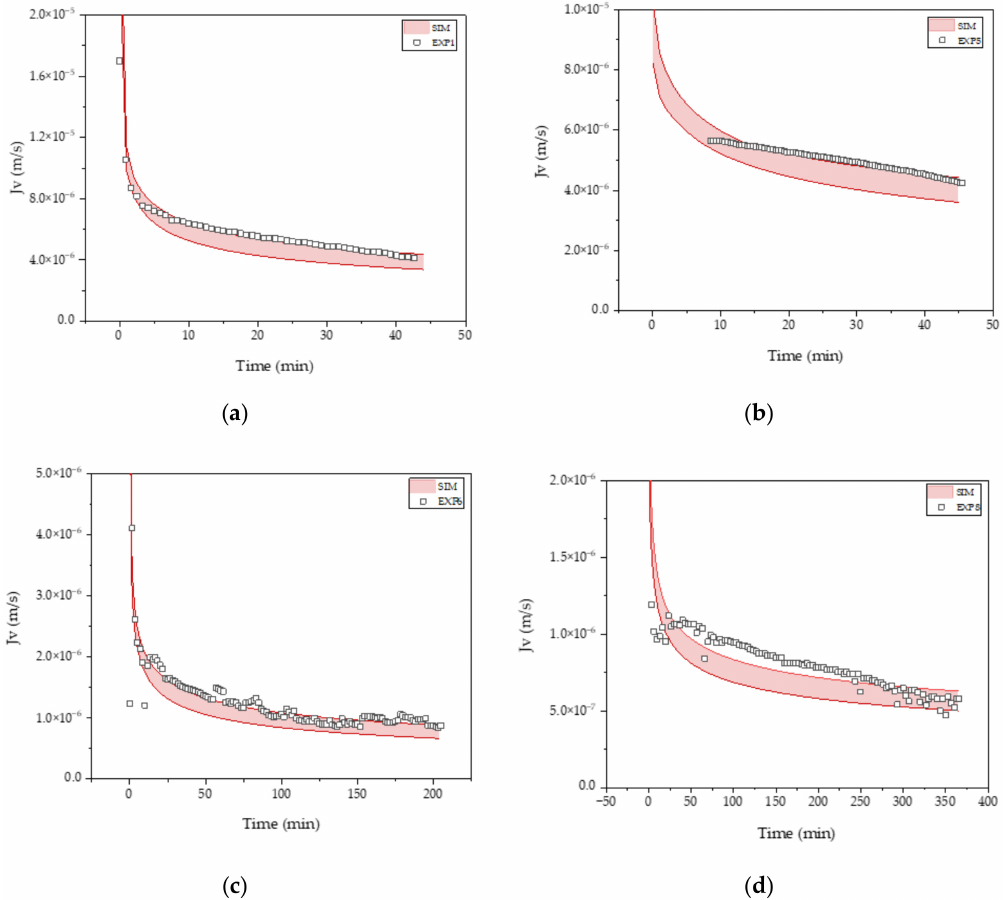
Figure 9. Flux Jv over time for experimental (squares) as well as digital twin prediction (red area) for ultrafiltration/diafiltration experiments and concentration factor 7. ( a ) Experiment 1 (EXP1): 1.5 bar transmembrane pressure (TMP), 3738 s − 1 shear rate. ( b ) Experiment 5 (EXP5): 0.5 bar TMP, 3738 s − 1 shear rate. ( c ) Experiment 6 (EXP6): 0.5 bar TMP, 1249 s − 1 shear rate. ( d ) Experiment 8 (EXP8): 1.5 bar TMP, 1249 s − 1 shear